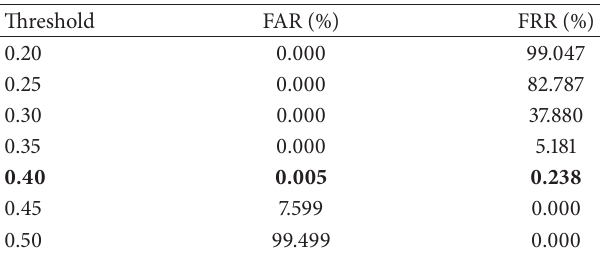
Table 2: Best FAR, FRR, and corresponding threshold for Experiment 1.